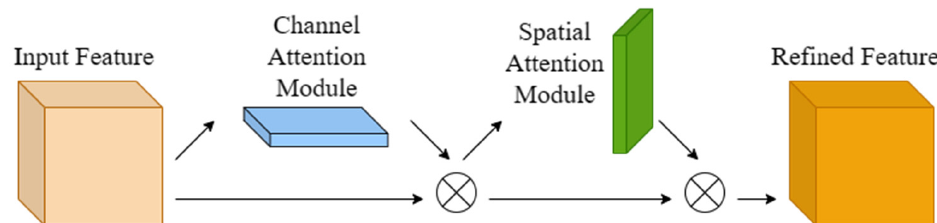
Figure 4. Schematic diagram of CBAM structure.